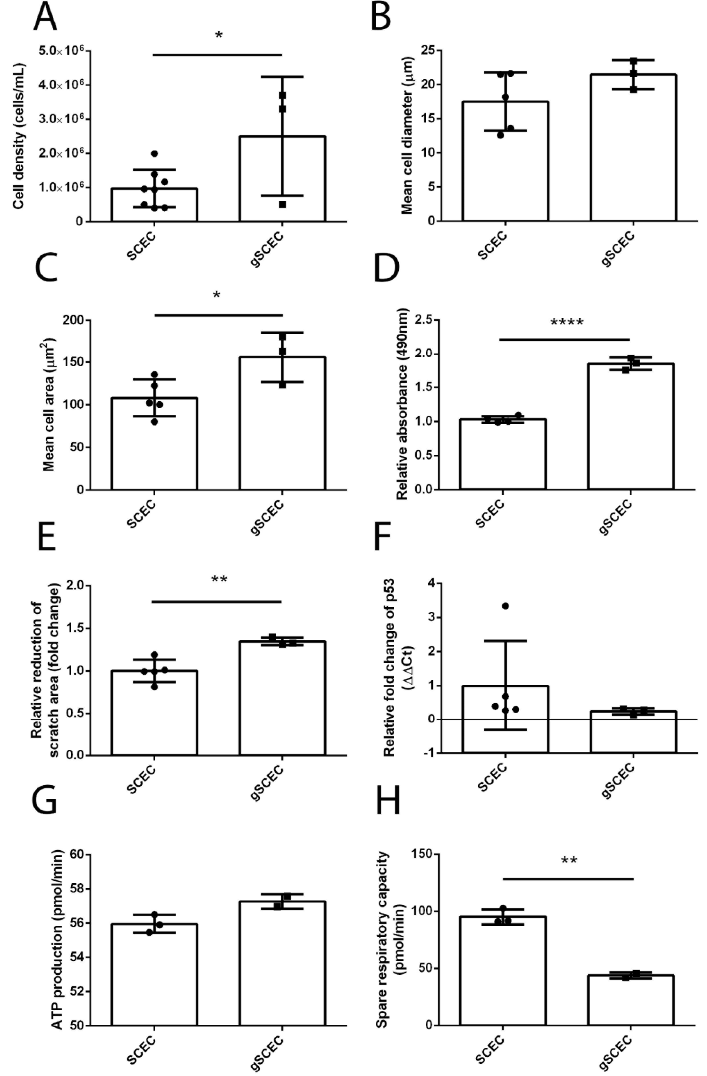
Figure 4. Increased cell size, proliferation, migration, and reduced mitochondrial activity observed in gSCECs, compared to heathy SCECs. A significant increase in cell density ( p = 0.0417, n = 8 for SCEC and n = 3 for gSCEC) was observed in gSCECs, compared to SCECs ( A ). A non-significant difference in the mean cell diameter of these seeded cells ( p = 0.1941, n = 5 for SCEC and n = 3 for gSCEC) was observed in gSCECs, compared to SCECs using the LUNA Automated Cell Counter ( B ). Using a separate method, a significant increase in mean cell area ( p = 0.0361, n = 5 for SCEC and n = 3 for gSCEC) was observed in gSCECs, compared to SCECs ( C ). A significant increase in cell proliferation ( p < 0.0001, n = 4 SCEC and n = 3 for gSCEC) ( D ) and cell migration ( p = 0.0054, n = 5 for SCEC and n = 3 for gSCEC) ( E ) was also observed in gSCECs, compared to SCECs. No significant difference in relative transcript expression of tumour suppressor p53 was observed between gSCECs and SCECs ( p = 0.3753, n = 5 for SCEC and n = 3 for gSCEC) ( F ). There was also no significant difference in ATP production observed between SCECs and gSCECs ( p = 0.0614, n = 3 for SCEC and n = 2 for gSCEC) ( G ). A significant reduction in spare respiratory capacity was observed, however, in gSCECs, compared to SCECs ( p = 0.0021, n = 3 for SCEC and n = 2 for gSCEC) ( H ). Mean ± SD is shown above, and statistical analysis was carried out using an unpaired Student’s t -test for all. Statistical significance was indicated by the following * = ( p < 0.05), ** = ( p < 0.01) and **** = ( p <